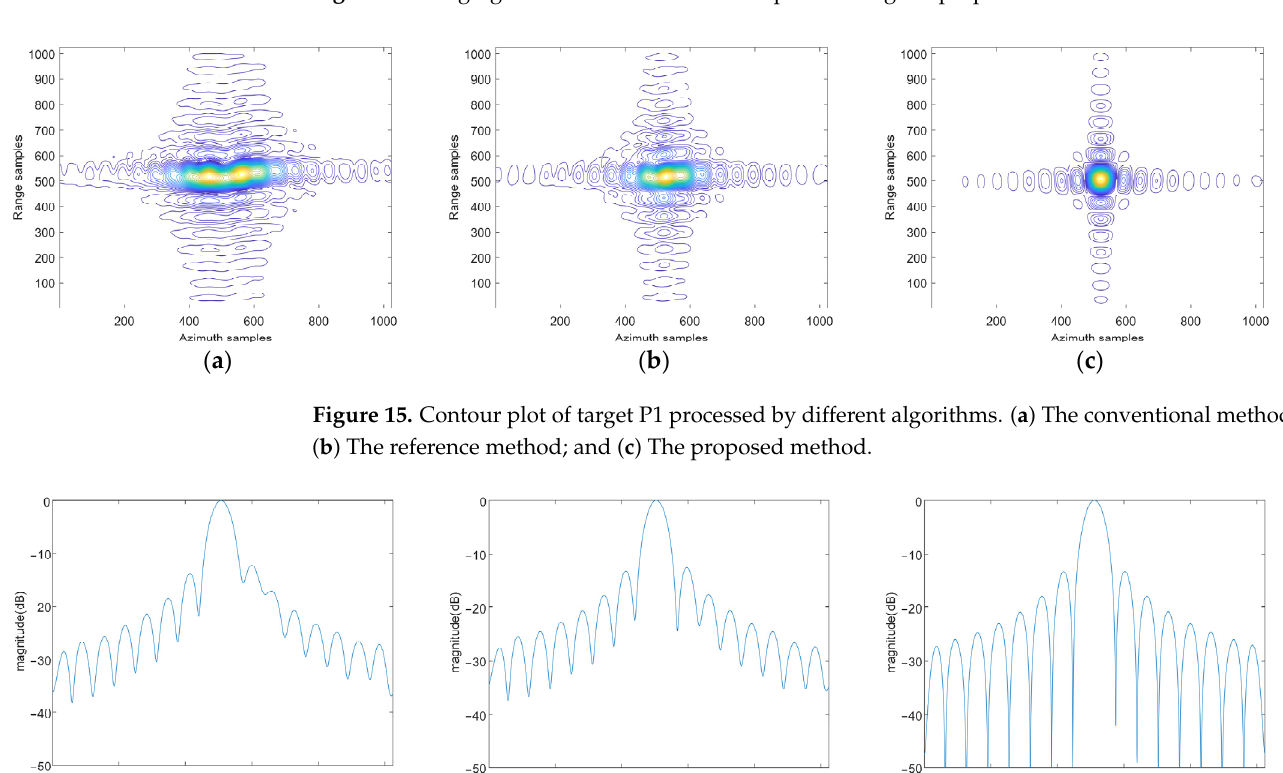
Figure 14. Imaging results of the 49 simulated points using the proposed method.